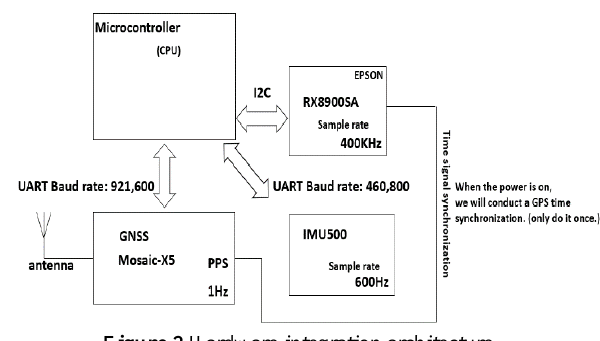
Figure 2 .Hardware integration architecture